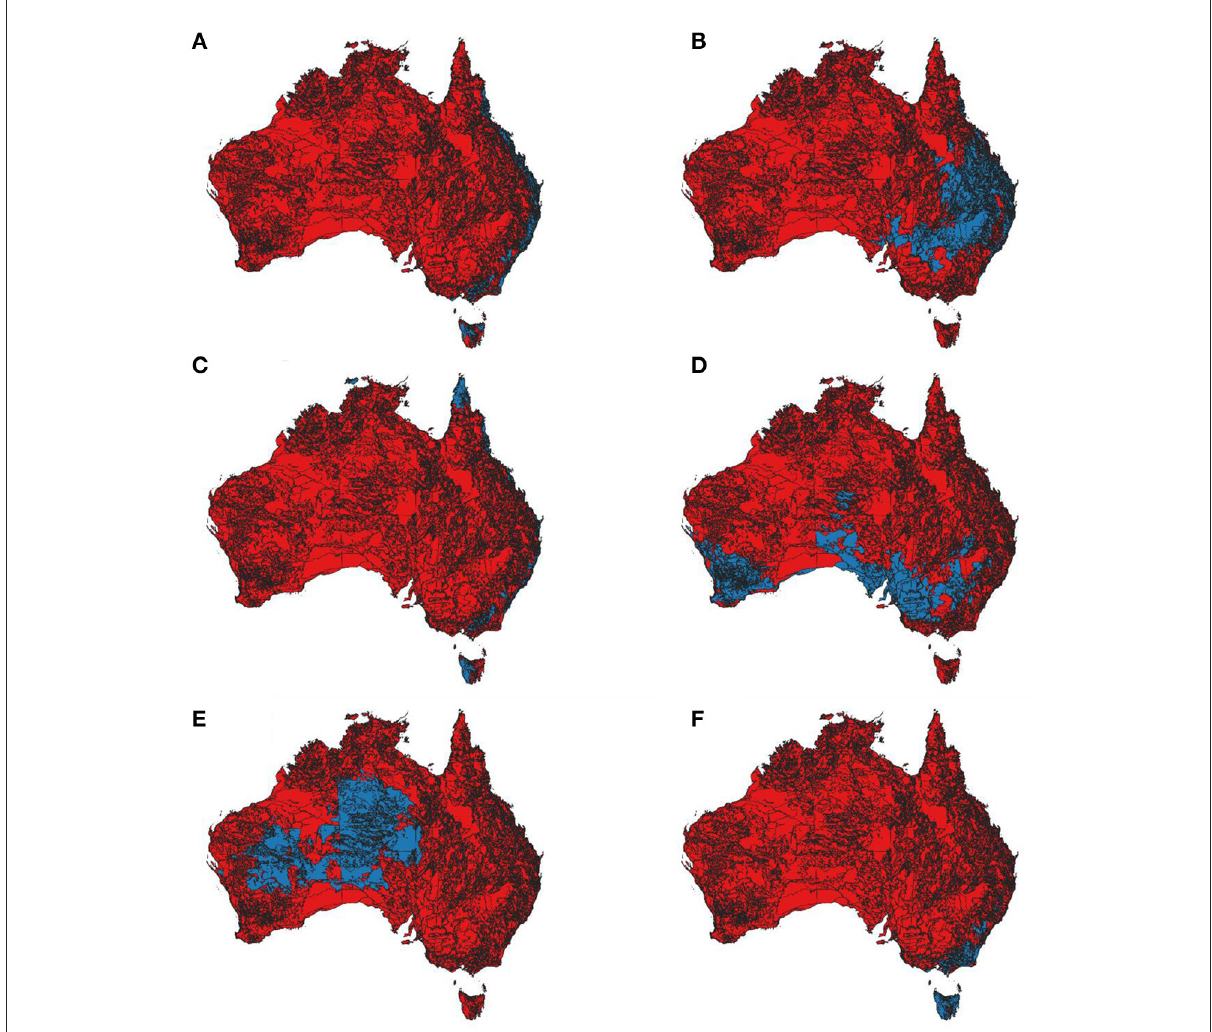
FIGURE2 Predicted suitability of the six native crops most used and in demand (Robbins, 2008). These include (A) Lemon Myrtle ( Backhousia citriodora ); (B) Native Citrus ( Citrus spp.); (C) Davidson Plum ( Davidsonia spp.); (D) Quandong ( Santalum acuminatum ); (E) Bush Tomato ( Solanum centrale ), and (F) Native Pepper ( Tasmannia lanceolata ). Blue indicated the suitable environmental range, while red indicates the unsuitable range, with locations delineated by soil order mapping and IBRA mapping (McKenzie et al., 2012; IBRA,